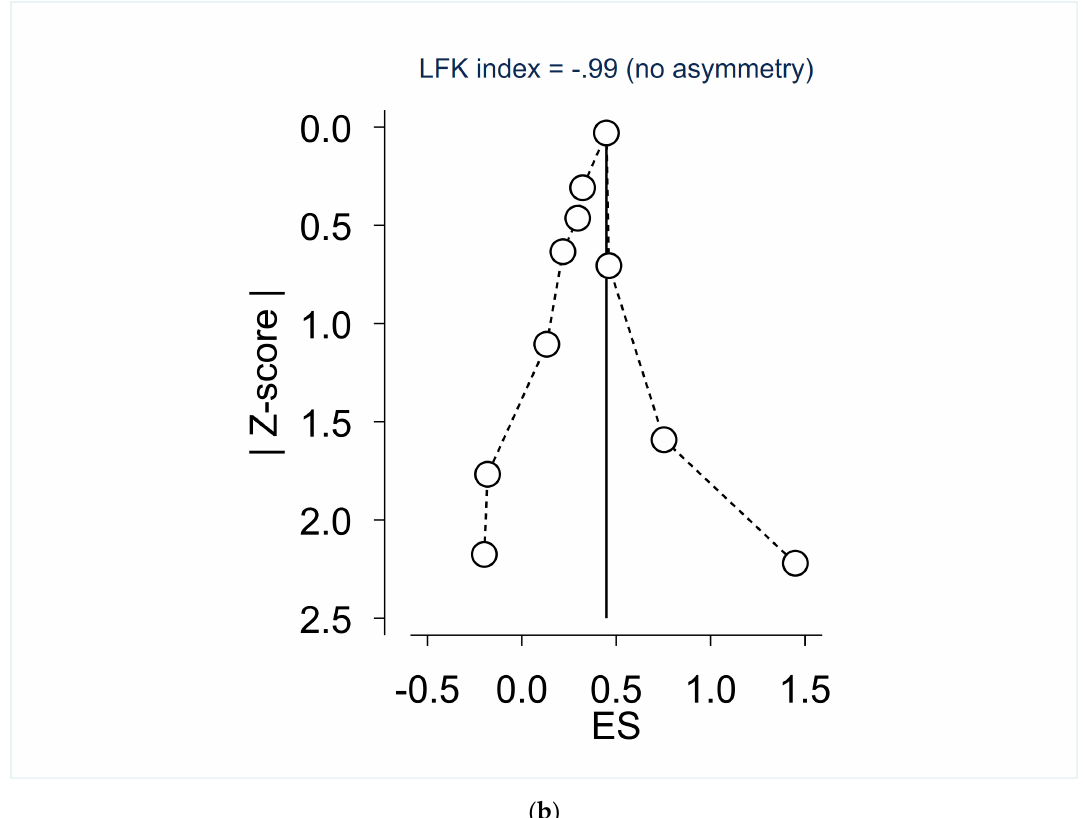
Figure 2. ( a ) The effects of nutritional and exercise interventions on body composition; ( b ) the symmetry of body composition results presented in Doi plot. ES, effect size.